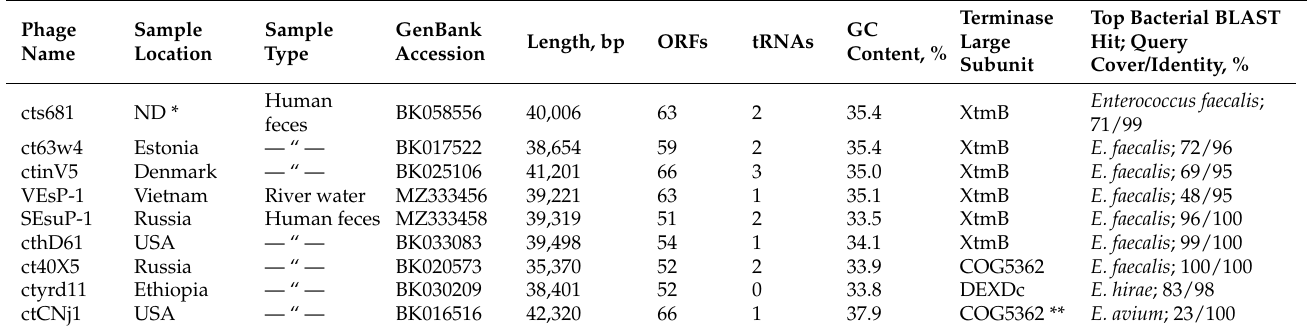
Table 1. The genomes belonging to the proposed genus “Vespunovirus”.